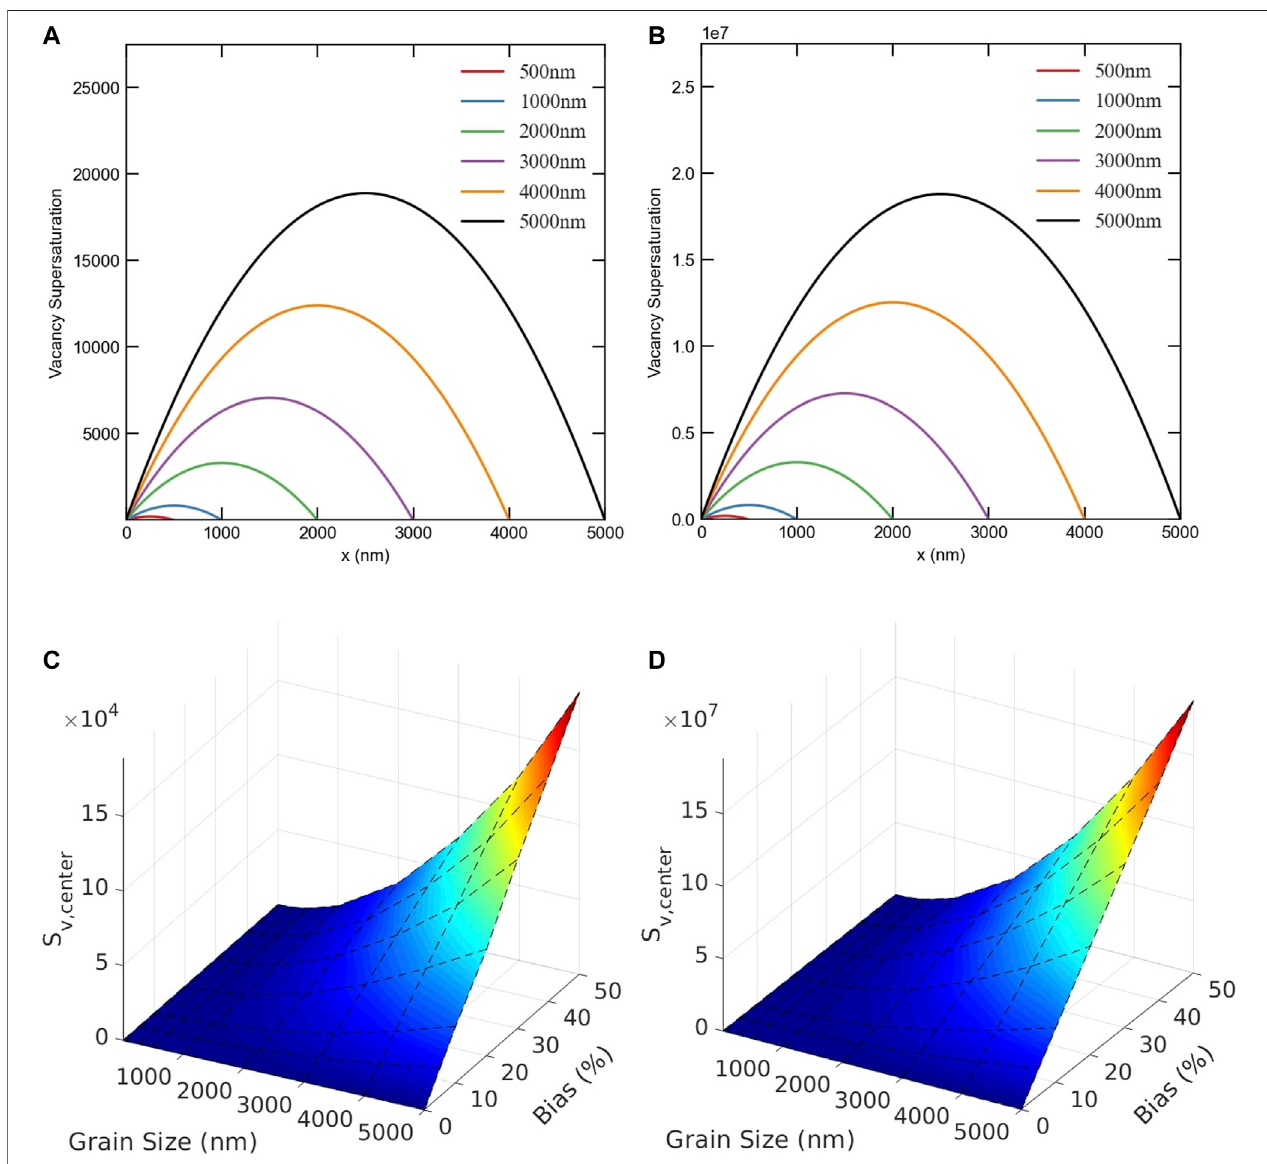
FIGURE 7 | The effects of dose rate, production bias, and size on vacancy supersaturation. Upper row : Vacancy supersaturation pro fi les for 5% production bias for (A) low dose rate (1e-6 dpa/s), and (B) high dose rate (1e-3 dpa/s). Lower row : Maximum vacancy supersaturation for different values of production bias and grain size for (C) low dose rate (1e-6 dpa/s), and (D) high dose rate (1e-3 dpa/s).